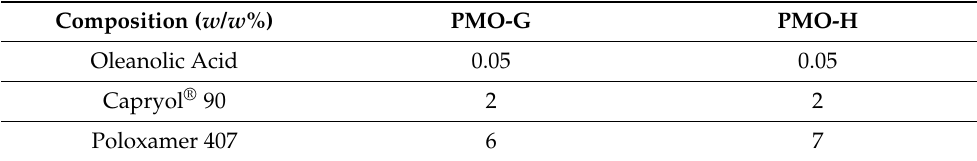
Table 2. Composition of micelles of oleanolic acid showing transparent liquid immediately after being diluted with distilled water